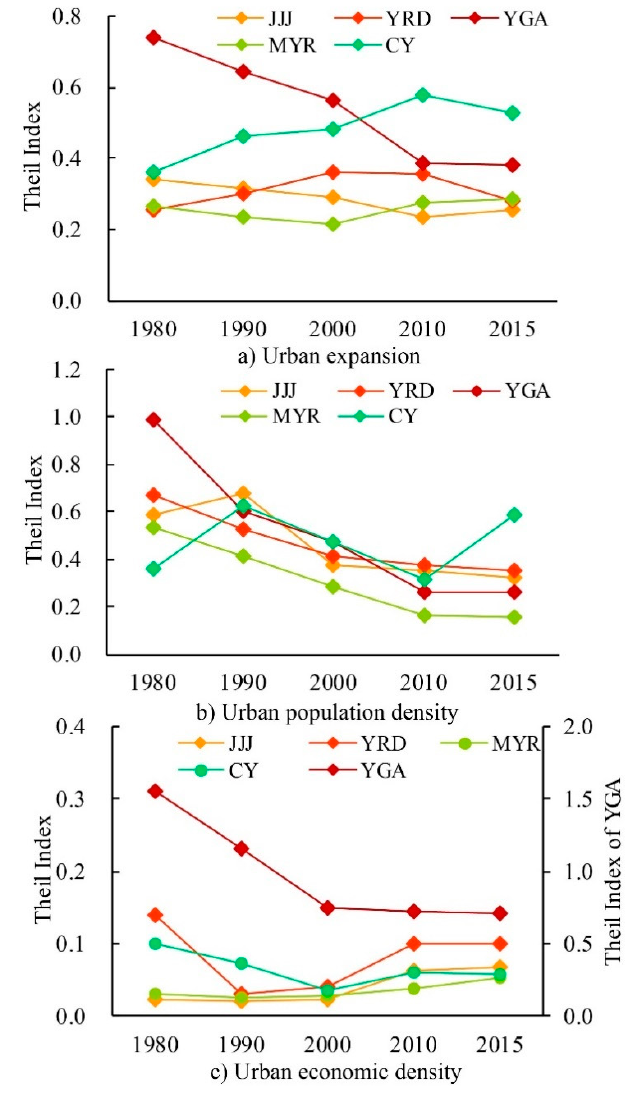
Figure 6. Changes in Theil index in different megaregions.